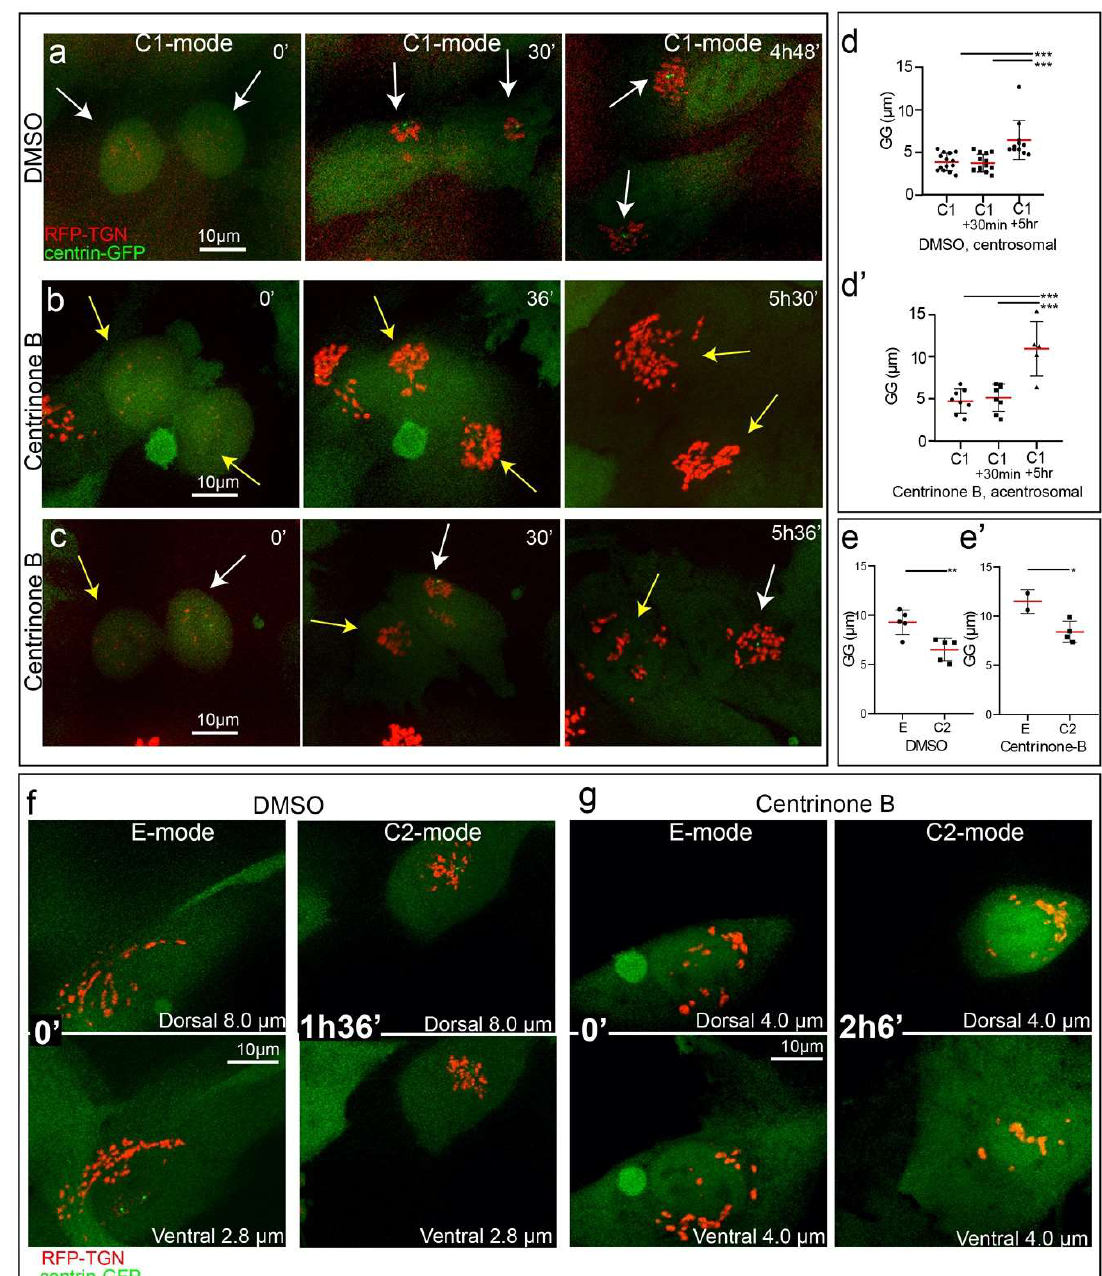
Figure 4. Golgi compaction is centrosome-independent. ( a – c ) Frames from time-lapse imaging sequences of dividing RPE1 cells stably expressing Golgi (RFP-TGN, red) and centrosome markers (centrin1-GFP, green), C1 mode progression within a 5 h period in control cell ( a ) or cells pretreated by Centrinone B for 72 h and containing no centrosomes ( b ) or one centrosome ( c ). Daughter cells with centrosomes, white arrows. Daughter cells without centrosome, yellow arrows. Note compact Golgi configuration in all daughter cells after the mitotic exit, and early E mode in acentrosomal cell at 5h. Scale 10 µm. Time, hours, minutes. ( d , d’ ) GG distance determined for control ( d ) and acentrosomal ( d’ ) cells at 6–12 min after mitotic exit is referred to as “C1”, 30 min and 5 h, referred to as “C1+30mins,” and “C1+5h”, respectively. Based on data as in ( a – c ). GG is low after mitotic exit regardless of the centrosome presence. At a later time point (5h), GG in acentrosomal cells is significantly higher than at the earlier time points (Student t -test, *** p < 0.001). It is also significantly higher than GG at 5h time point in DMSO (Student t -test, ( p < 0.01). n = 11). ( e,e’ ) GG distance